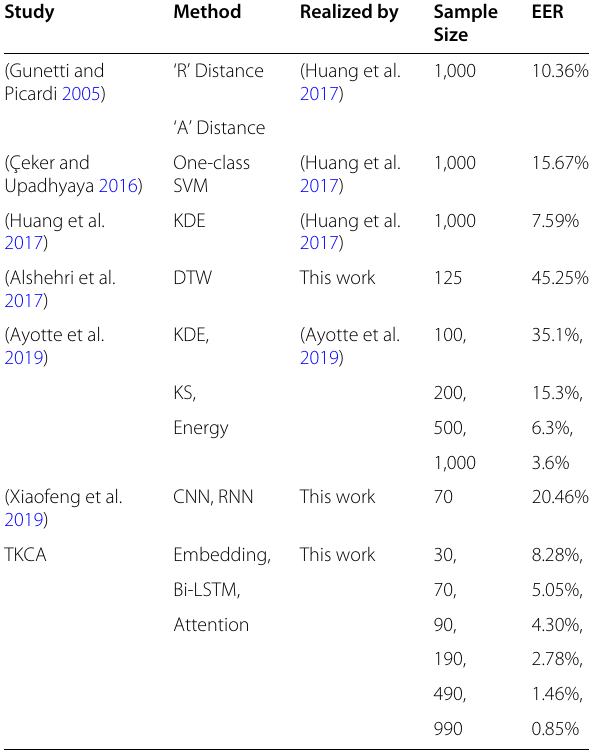
Table 7 The comparison of TKCA with previous KCA